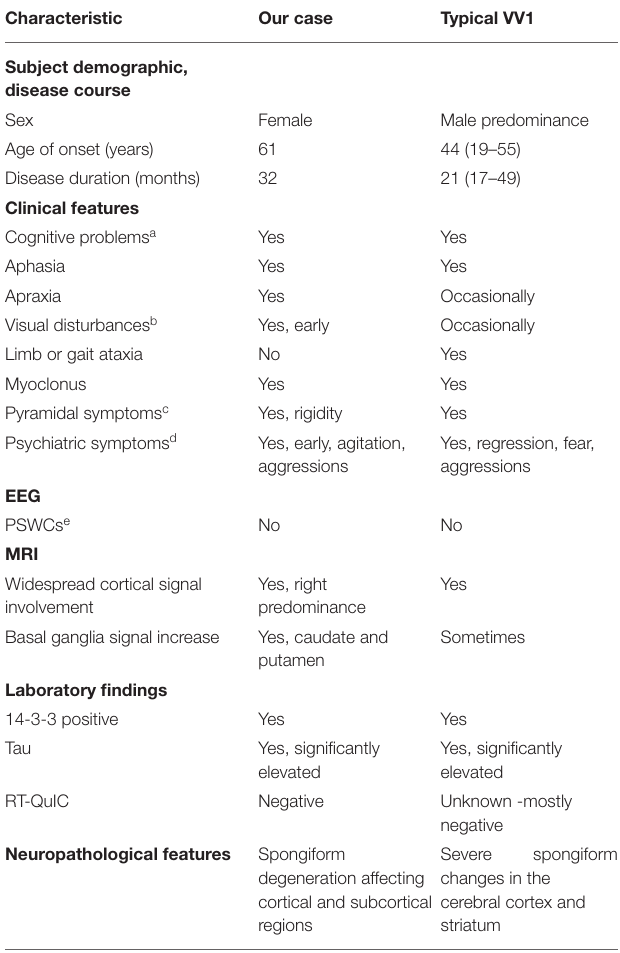
TABLE 1 | Comparison of typical VV1 characteristics and our